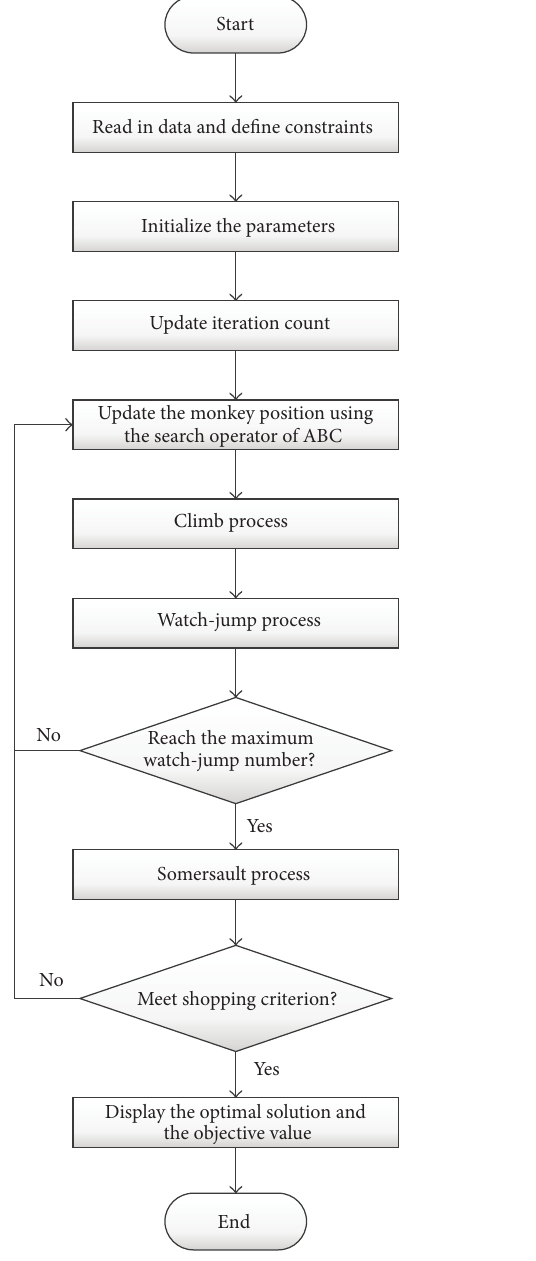
Figure 3: The flow chart of ABC-MA.